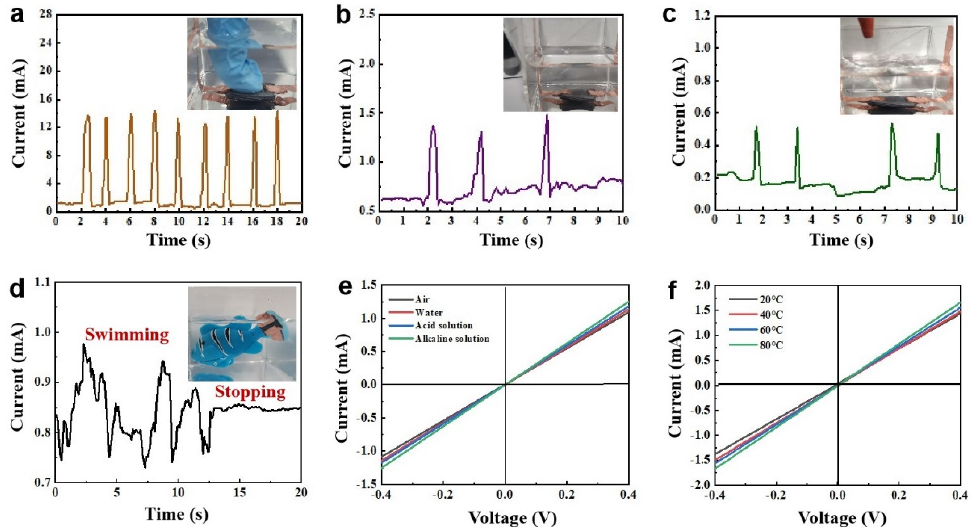
Figure 4. Resistive response and durability testing of sensors to different underwater behaviors. ( a ) Press the sensor in the water. ( b ) Tap the vessel wall with tweezers. ( c ) Blow on the water with an ear washing ball. ( d ) The resistance response curves of the small fish moving and stopping state; the inset is the simulated fish swimming mode to detect fish tail swing. ( e ) I − V response curves in different pH solutions. ( f ) I − V response curves of the sensor under different water temperature conditions.